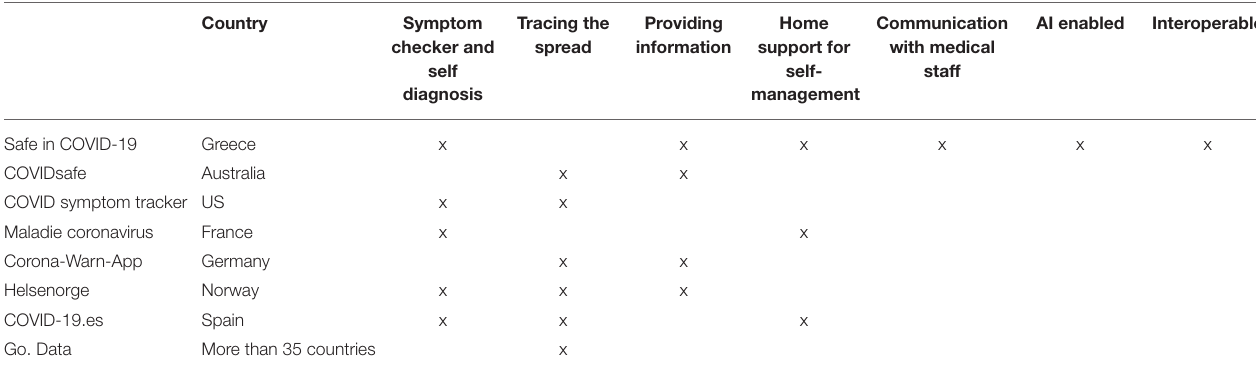
TABLE 1 | A comparison of the features of key platforms for COVID-19.